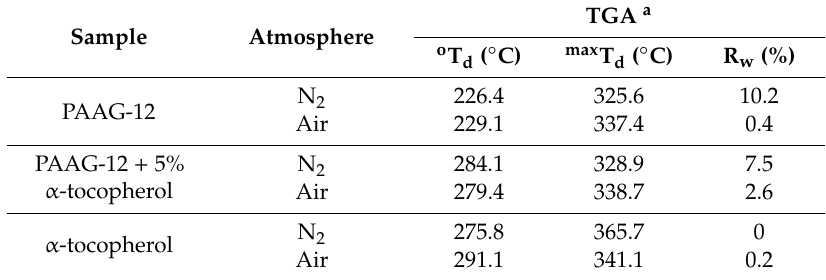
Table 1. Values of TGA of the PAAG-12 control film, the film charged with 5% α -tocopherol and α -tocopherol film in nitrogen and air atmospheres.